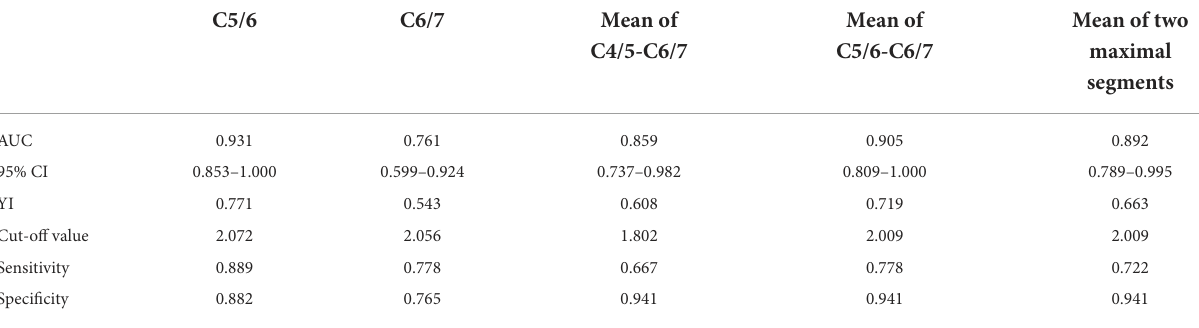
TABLE 7 Parameters derived from ROC curve analysis according to flexion ADC